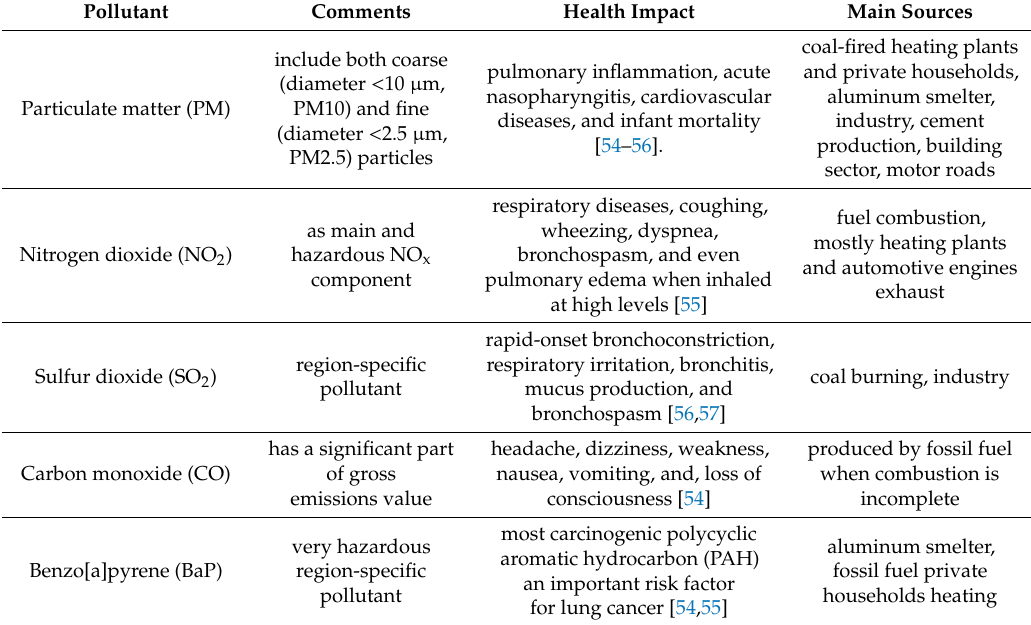
Table 3. The pollutants and their characteristics modeled in the